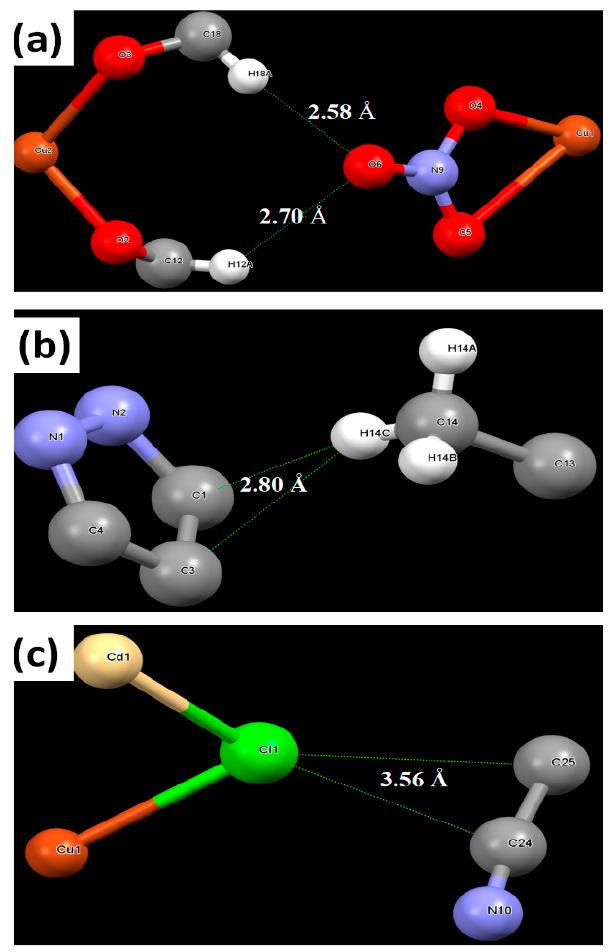
Table 2. Geometric parameters (Å, degree) for C-H…O